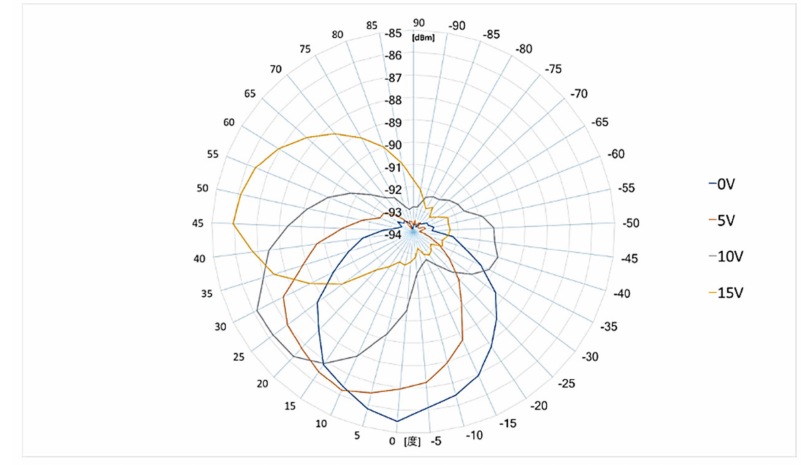
Figure 9. The results of RSSI by the voltage differentials in each antenna element with the prototype system.